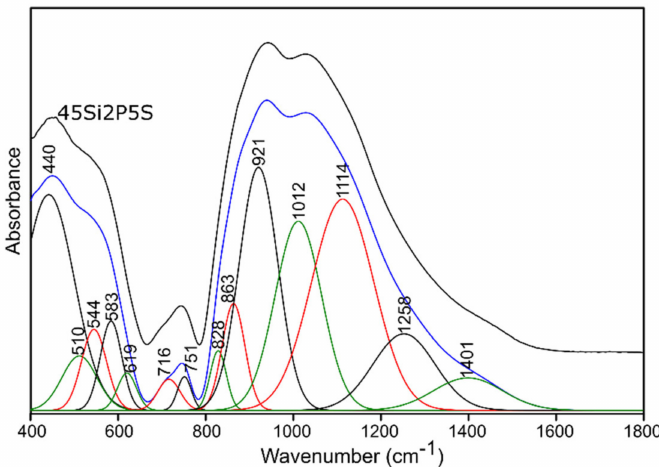
Figure 7. Deconvolution of the MIR spectra of the 45Si2P5S glass sample.